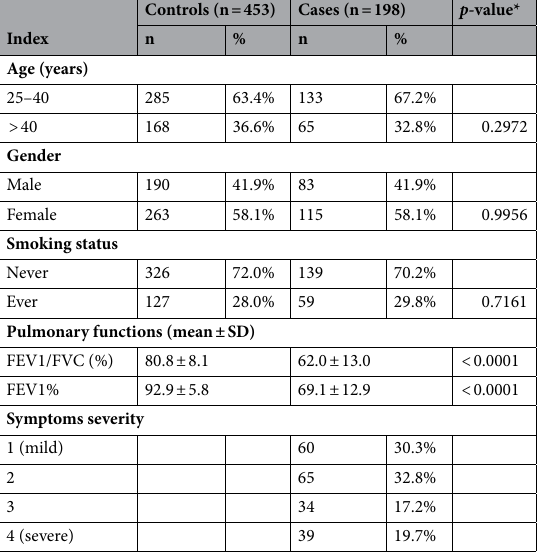
Table 1. Distributions of baseline characteristics among the 198 asthmatic patients and 453 controls. FEV1 forced expiratory volume in first second, FVC forced vital capacity, FEV1% percent of predicted FEV1. *Chi- square without Yate’s correction test or Student’s t-test.